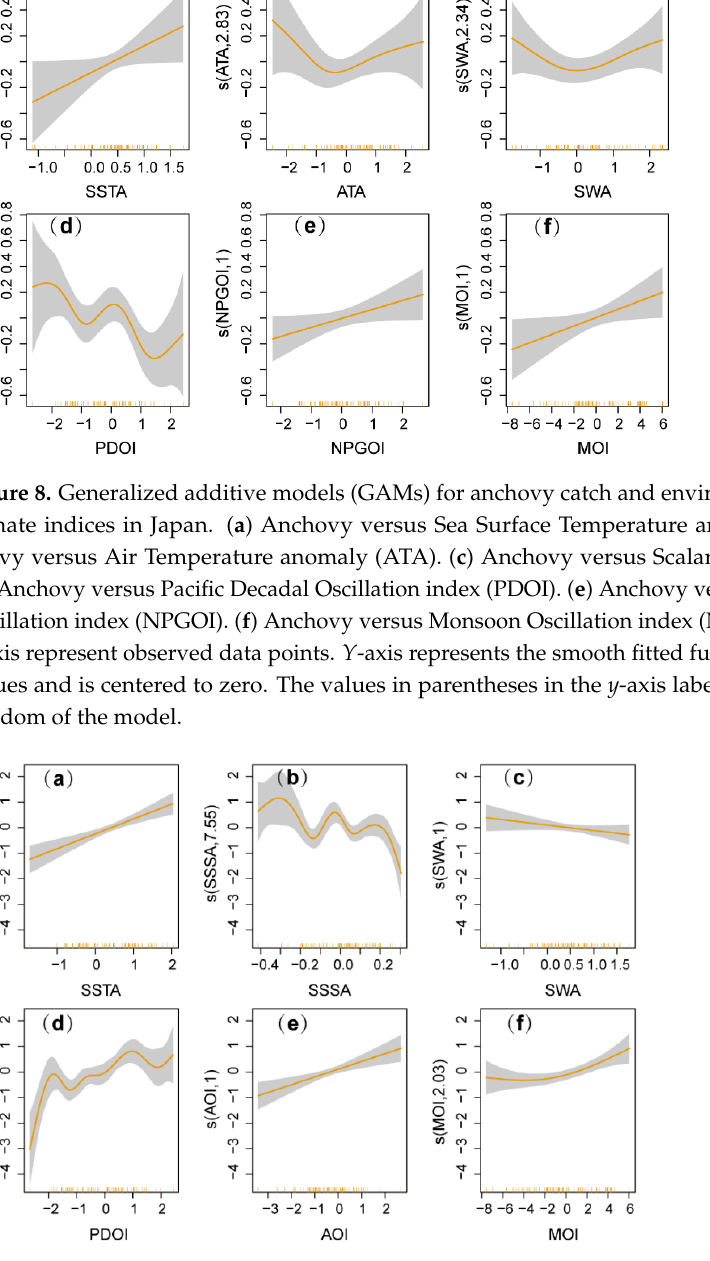
Figure 9. Generalized additive models (GAMs) between anchovy catch and environmental variables and climate indices in Korea. ( a ) Anchovy versus Sea Surface Temperature anomaly (SSTA). ( b ) Anchovy versus Sea Surface Salinity anomaly (SSSA). ( c ) Anchovy versus Scalar Wind anomaly (SWA). ( d ) Anchovy versus Pacific Decadal Oscillation index (PDOI). ( e ) Anchovy versus Arctic Oscillation index (AOI). ( f ) Anchovy versus Monsoon Oscillation index (MOI). Tick marks on the x -axis represent observed data points. Y -axis represents the smooth fitted function of the dependent values and is centered to zero. The values in parentheses in the y -axis label indicate the degree of freedom of the model.